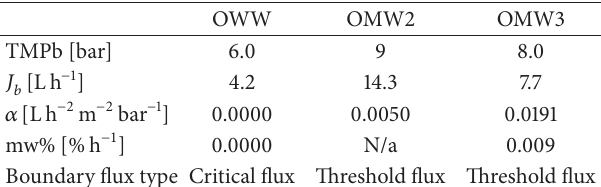
Table 5: NF boundary flux values for OWW, OMW2, and OMW3.